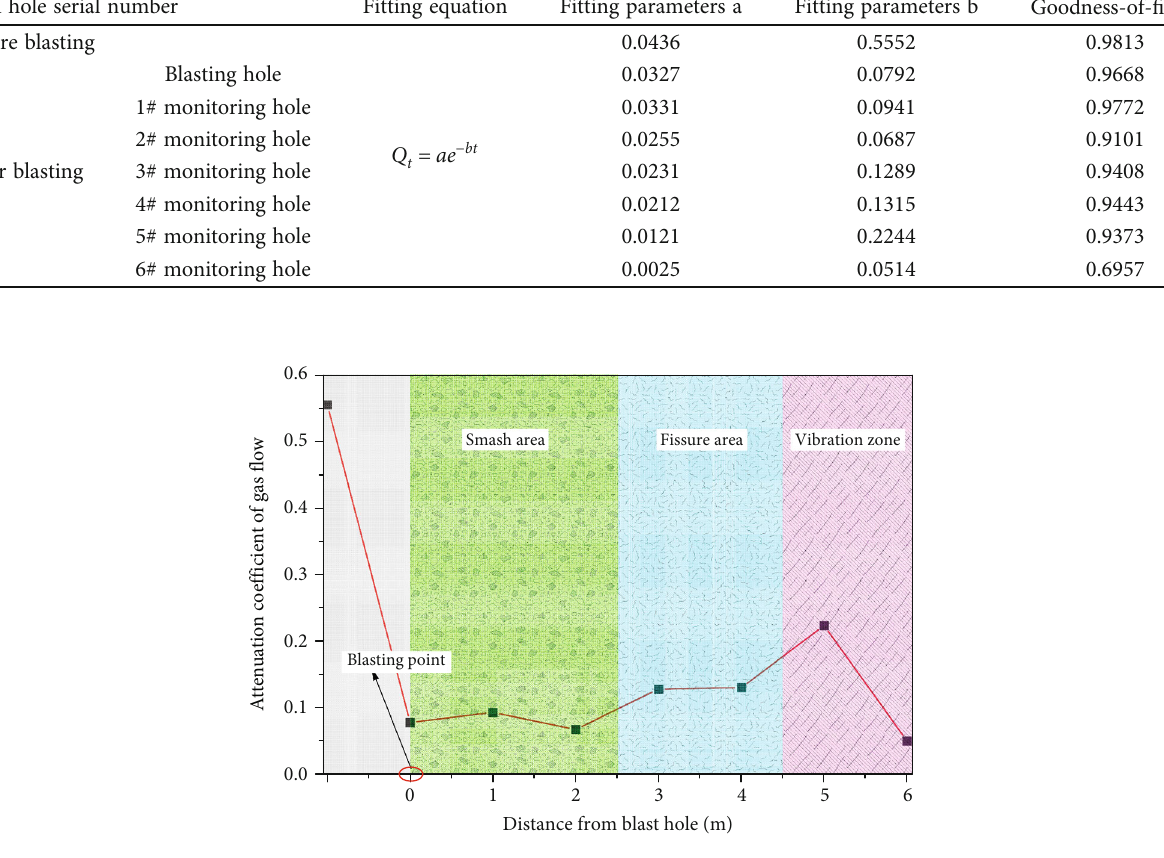
Figure 17: Natural methane fl ow attenuation coe ffi cient of each borehole with